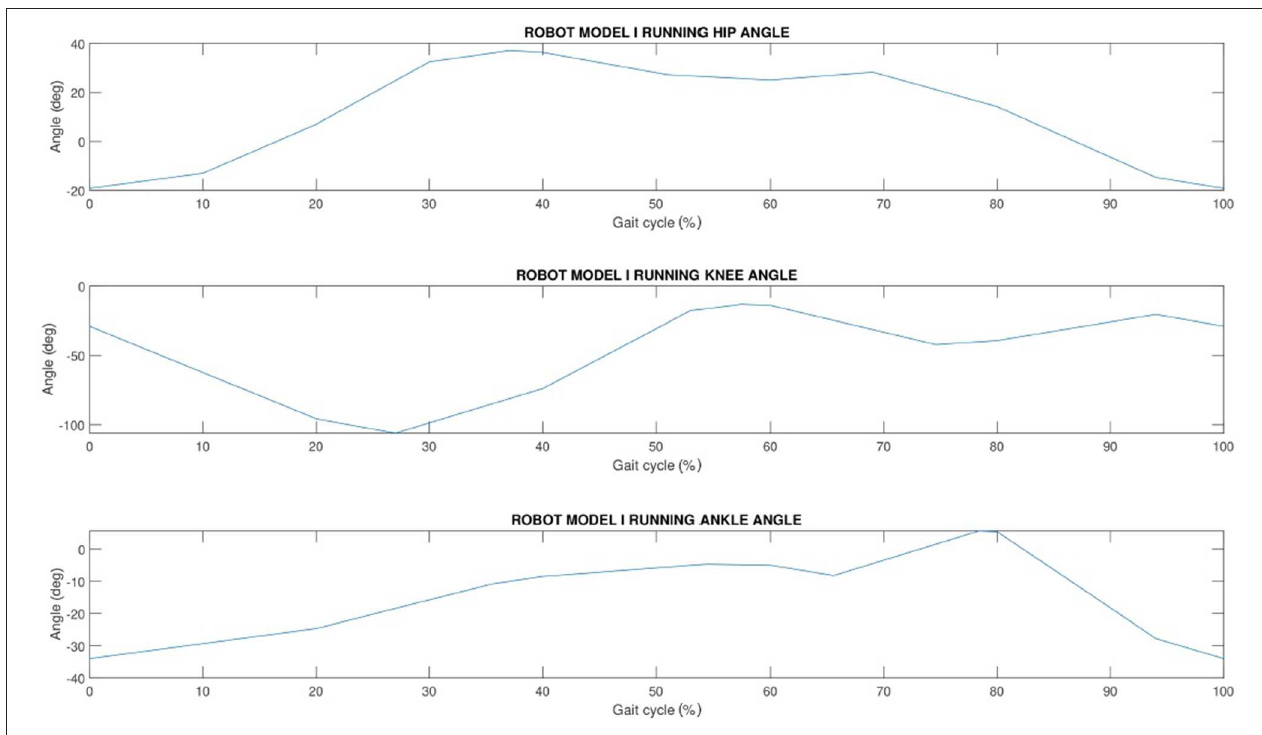
FIGURE 4 | Joint angle input for Robot model I running gait.